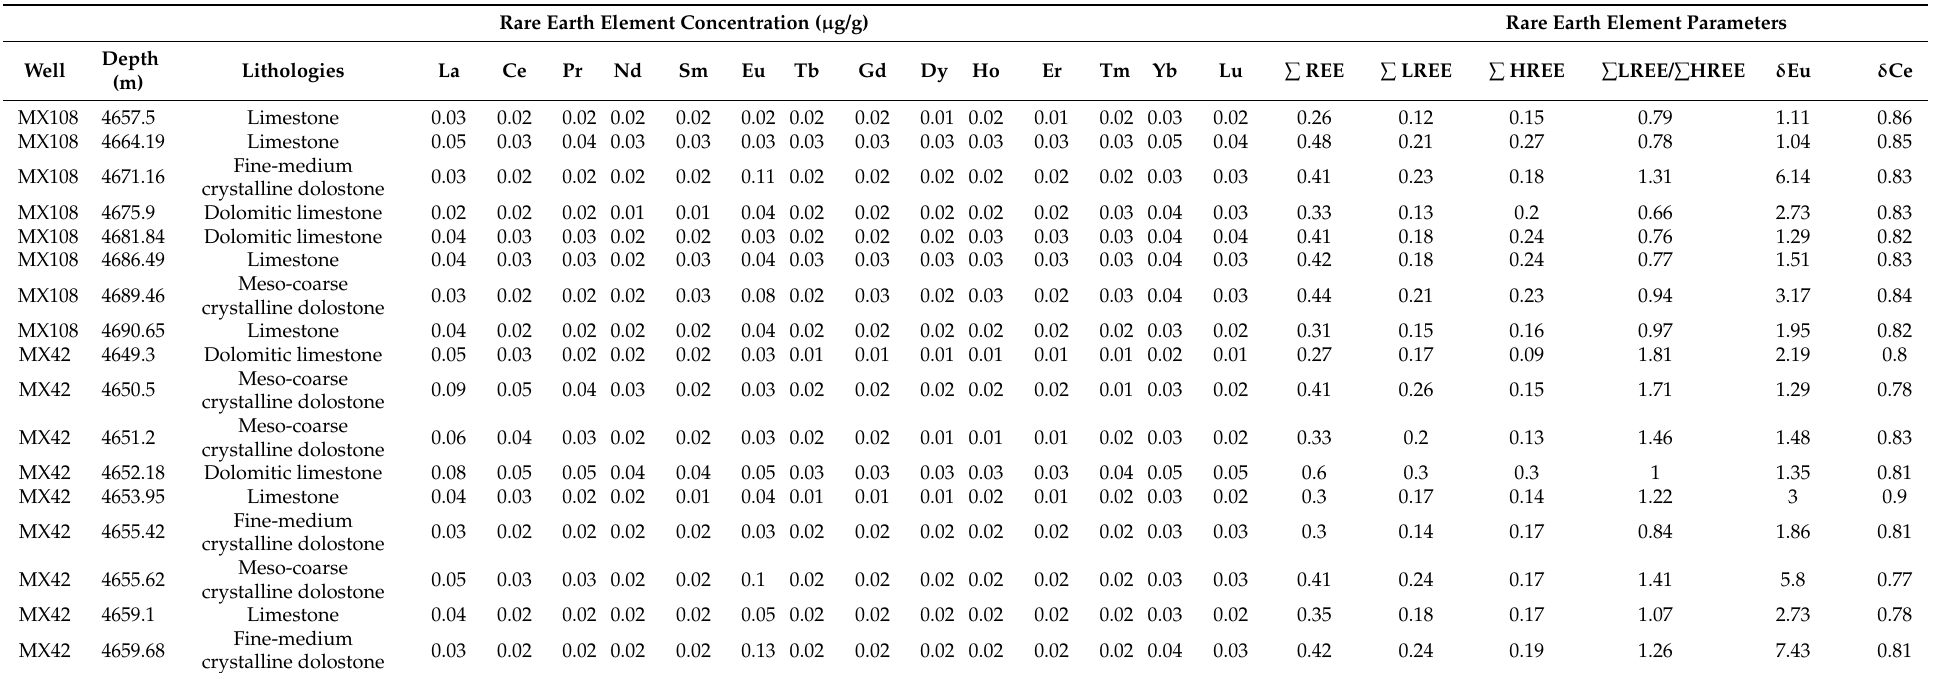
Table 3. Rare earth element composition of carbonate rocks from the Qixia